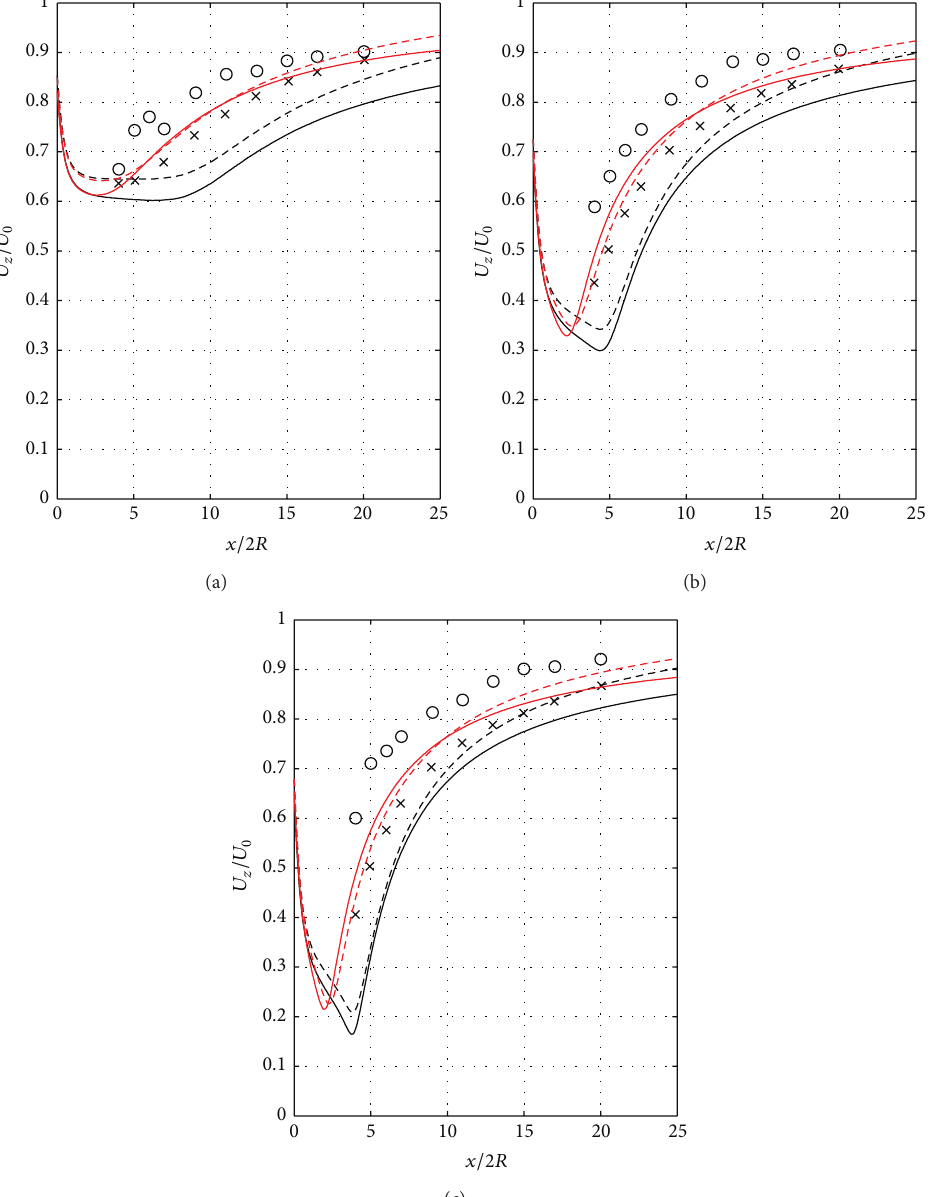
Figure 5: Velocity along the centre line showing the channel (solid line), duct (dashed line), numerical ( × ) [4], and experimental data ( ⃝ ) [11] for the 𝐶 𝑇 values of (a) 0.61, (b) 0.86, and (c) 0.97 for the experimental study [11]. The inlet 1 simulations are shown in black and inlet 2 simulations are in